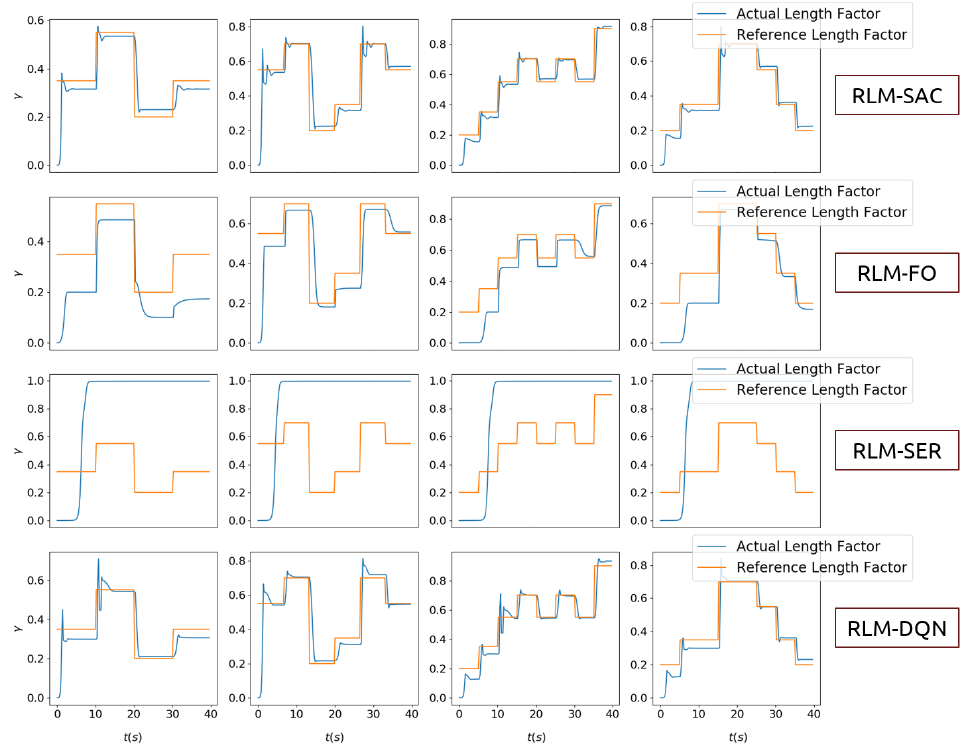
Figure 8. Illustration of some reference trajectories and the performance of each RL method.